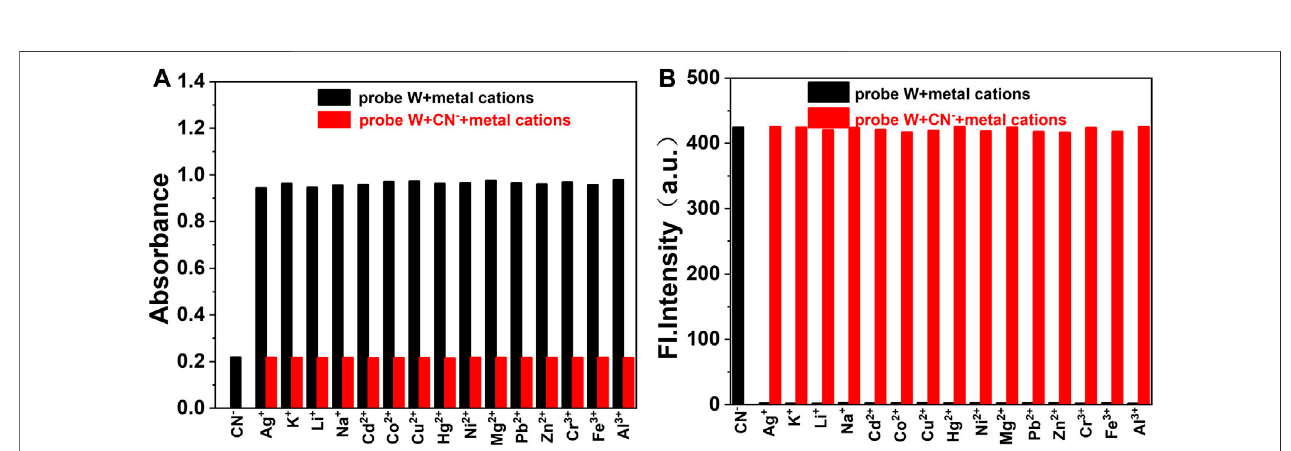
FIGURE6| Bardiagramofthecompetitiveexperimentsofvariousmetalcationsontheabsorbance (A) and fl uorescenceintensity (B) oftheprobe/CN − complexin buffer solution ( λ ex/ λ em = 378 nm/478 nm, slit: 5/5 nm, and voltage: 500 V).